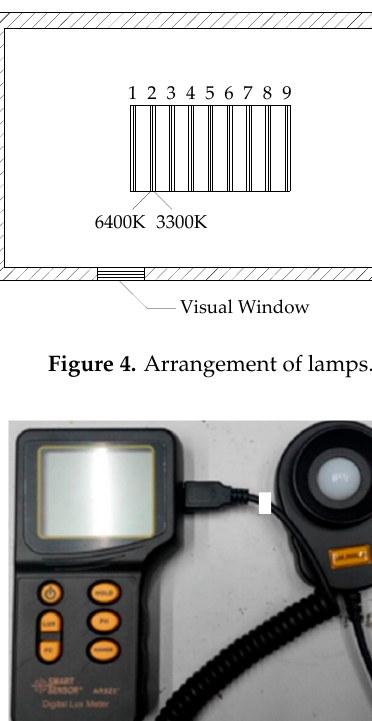
Figure 5. Photometer.